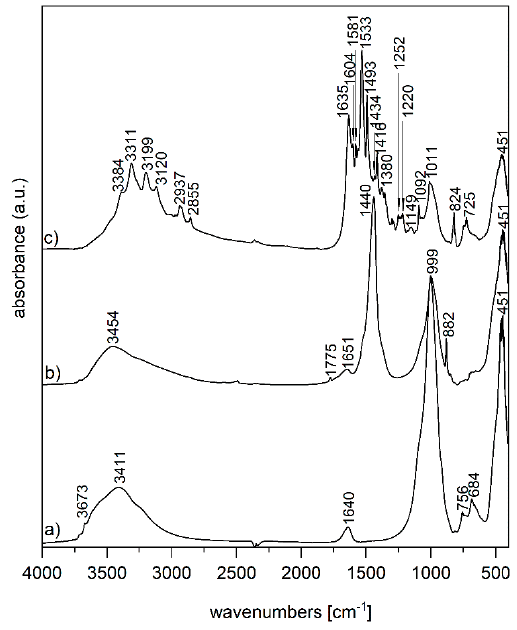
Figure 2. FTIR spectra of the nanofiller samples: a) V, b) ZnO/V and c) ZnO/V_CH.